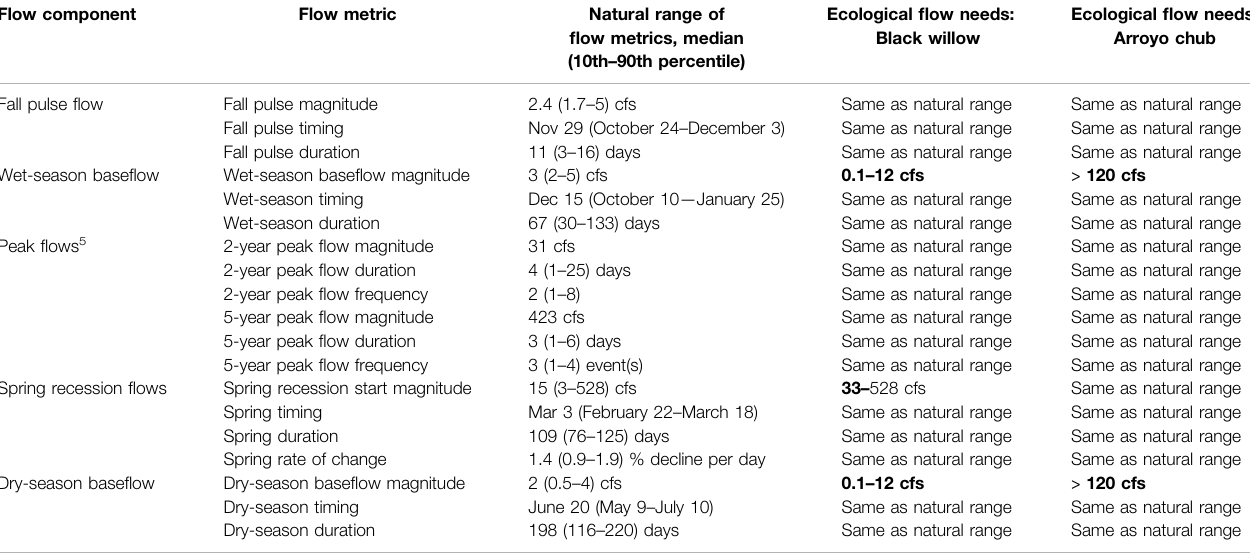
TABLE 5 | Natural range of fl ow metrics from CEFF Section A and ecological fl ow needs for black willow and arroyo chub from CEFF Section B. Flow component Natural range of